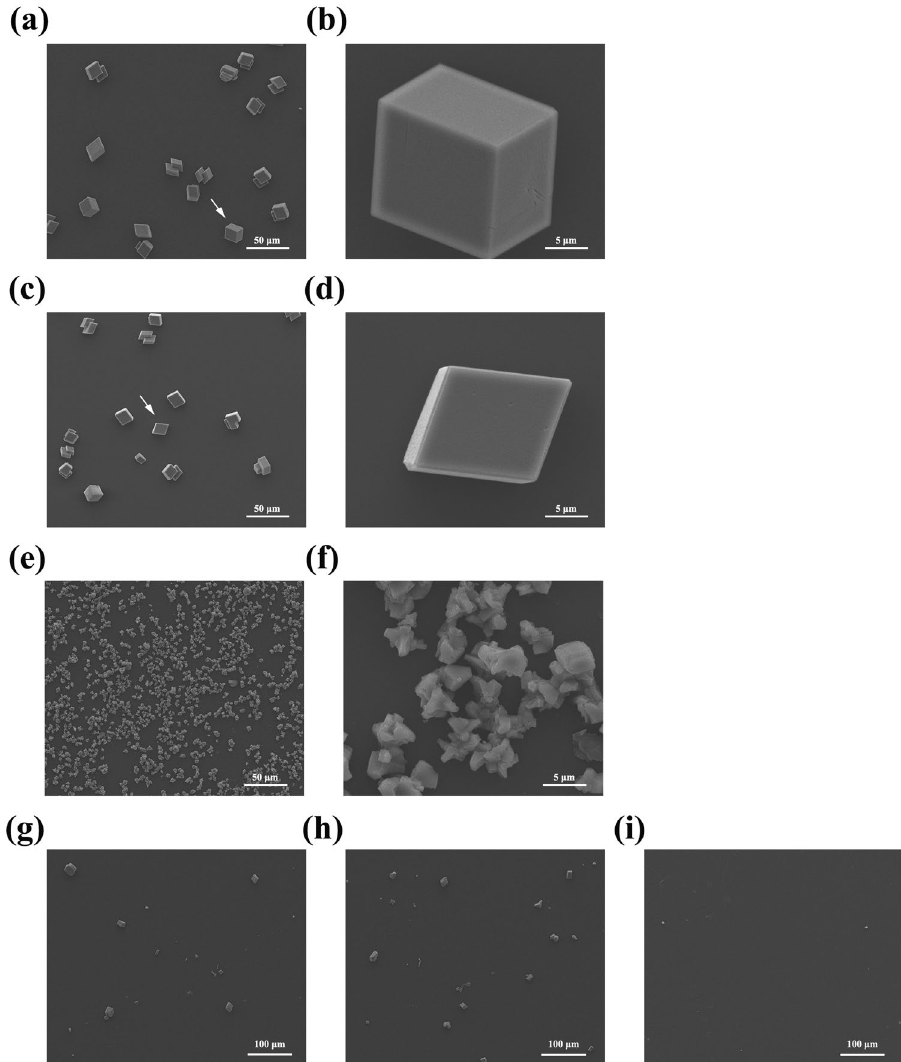
Figure 9. SEM images of crystals formed in the crystal growth inhibition experiments. SEM pictures of crystals grown in the presence of 10 μ g/ml BSA ( a , b ); 10 μ g/ml MBP ( c , d ); 10 μ g/ml rPfY2 ( e , f ). ( b , d , f ) were the amplifications of the crystals indicated by arrows in ( a , c , e ), respectively. The final concentration of CaCl 2 and NaHCO 3 was 50 mM in ( a – f ) and 5 mM in ( g – i ). ( g ) 10 μ g/ml BSA group; ( h ) 10 μ g/ml MBP group; ( i ) 10 μ g/ ml rPfY2 group. Almost no crystal formed in the presence of 10 μ g/ml rPfY2 when the concentration of Ca 2 + reduced to 5